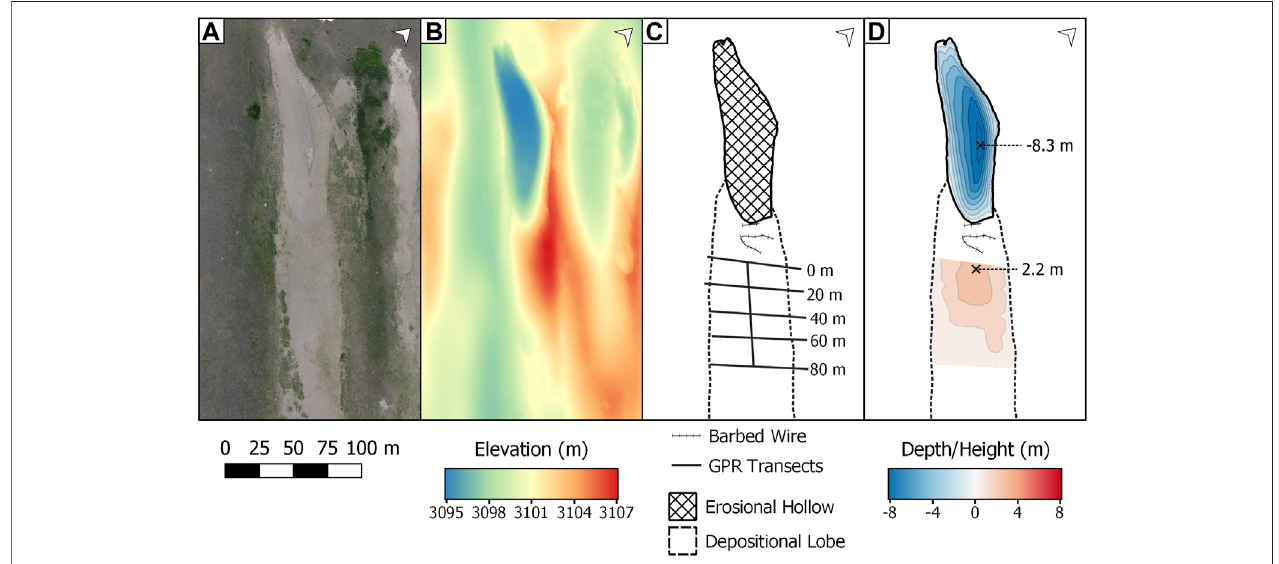
FIGURE 7 | Blowout B viewed as ( A ) a true color composite; ( B ) a digital elevation model; ( C ) a schematic model with ground-penetrating radar transects; and ( D ) interpolated lobeheightand hollowdepth(contoursat 1 mspacing).Notethedepositionallobesituated on anincline.Coordinates ofthetop-leftcorner ofthebounding box: 35.96427N, 100.27499E; bottom-right corner: 35.96310N, 100.27839E.